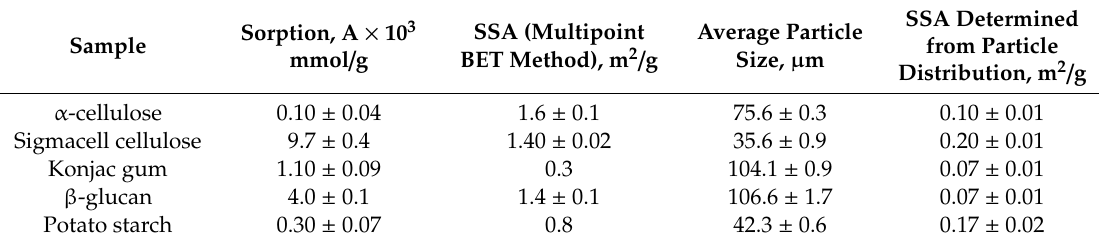
Figure 4. The isothermal kinetics of sorption of methylene blue onto sigmacell cellulose in ethanol. Table 2. Sorption of methylene blue onto biomass carbohydrates and comparison of the results to the data obtained using other methods.